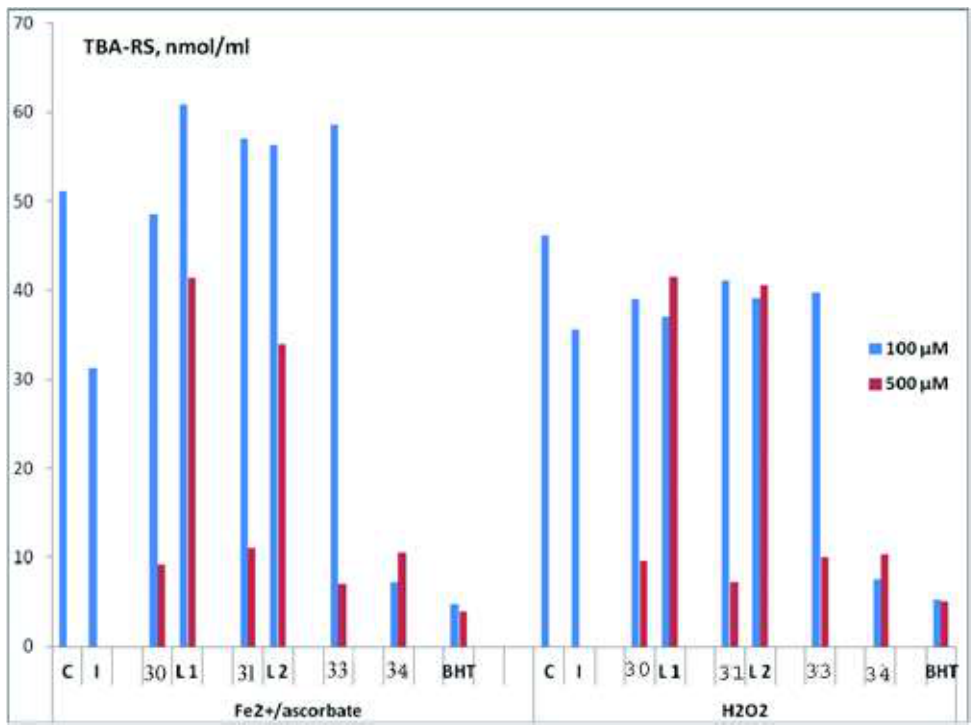
Figure 5. Antioxidant performance of the test compounds (Cu chelates 30–33, ligands L 1 (34) & L 2 (35)) at concentrations of 100 and 500 μM. C—Control without test compounds. I—intact samples (without initiated oxidation). BHT—standard antioxidant 2, 6-di-tert-butyl-4-methylphenol. Reproduced from the permission of ref. [144].